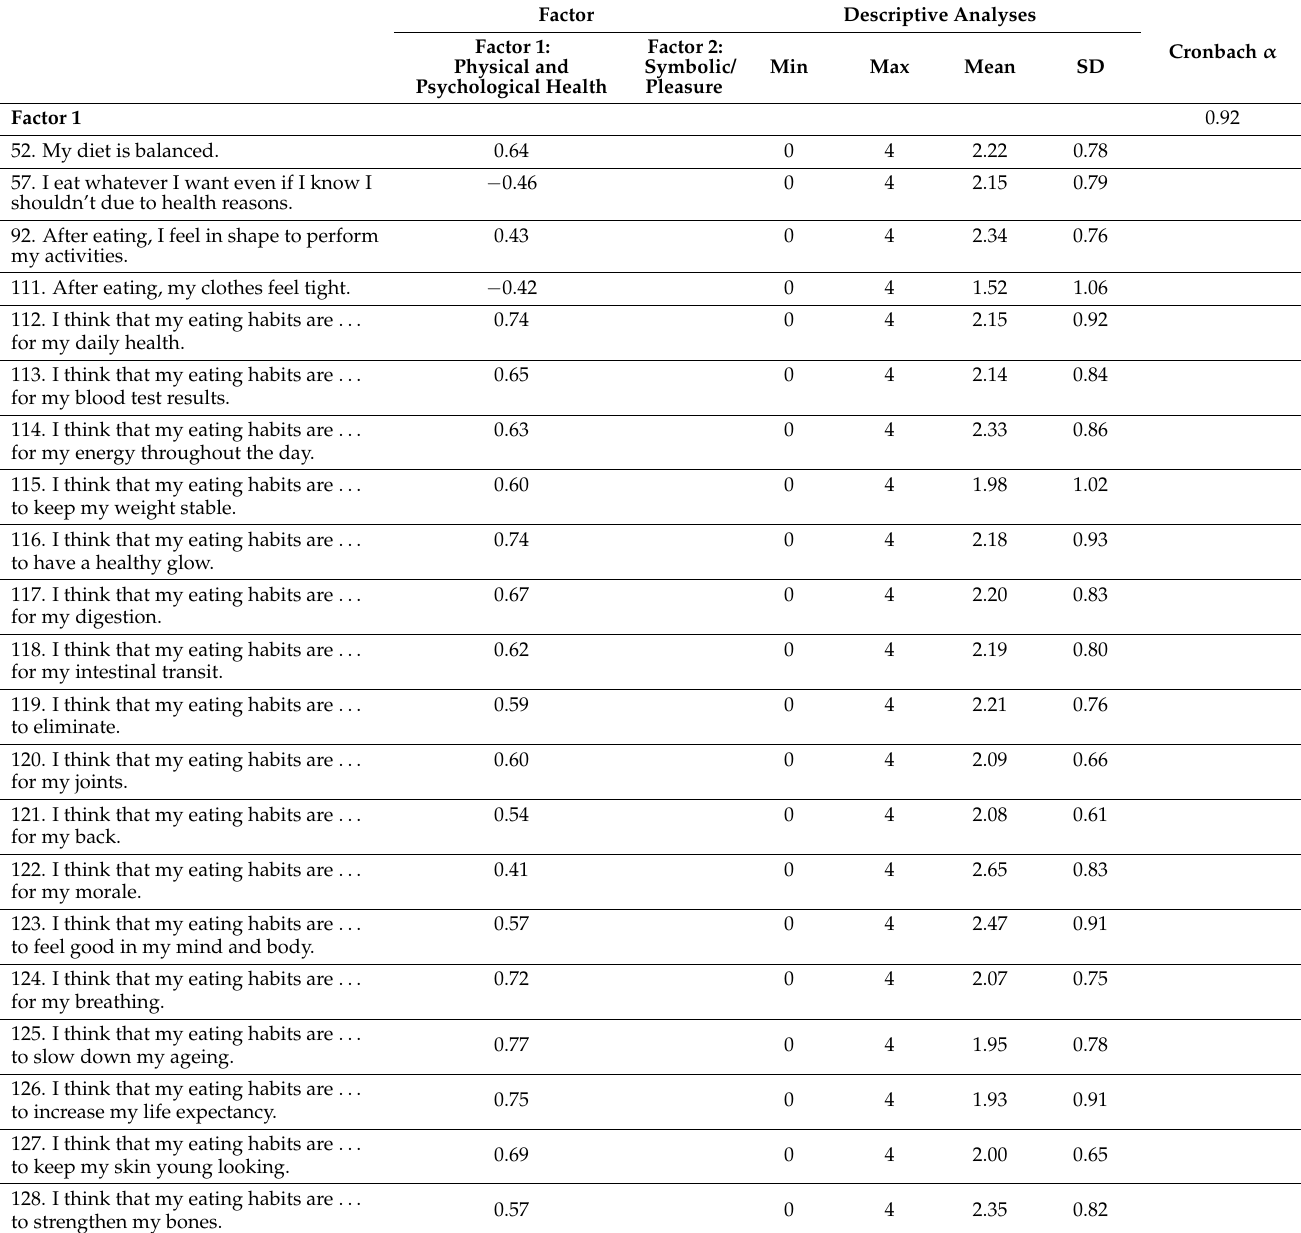
Table 3. Exploratory factor analysis with orthogonal rotation and descriptive analysis. Descriptive